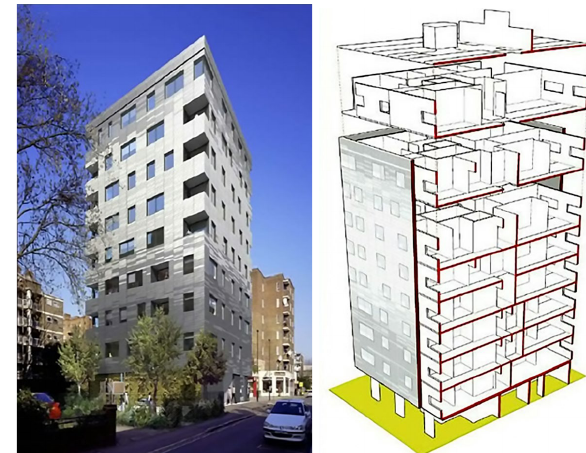
Figure 7. Murray Grove Stadthaus , London, UK (Cvetkovic, Stojić, Krasic, & Marković,